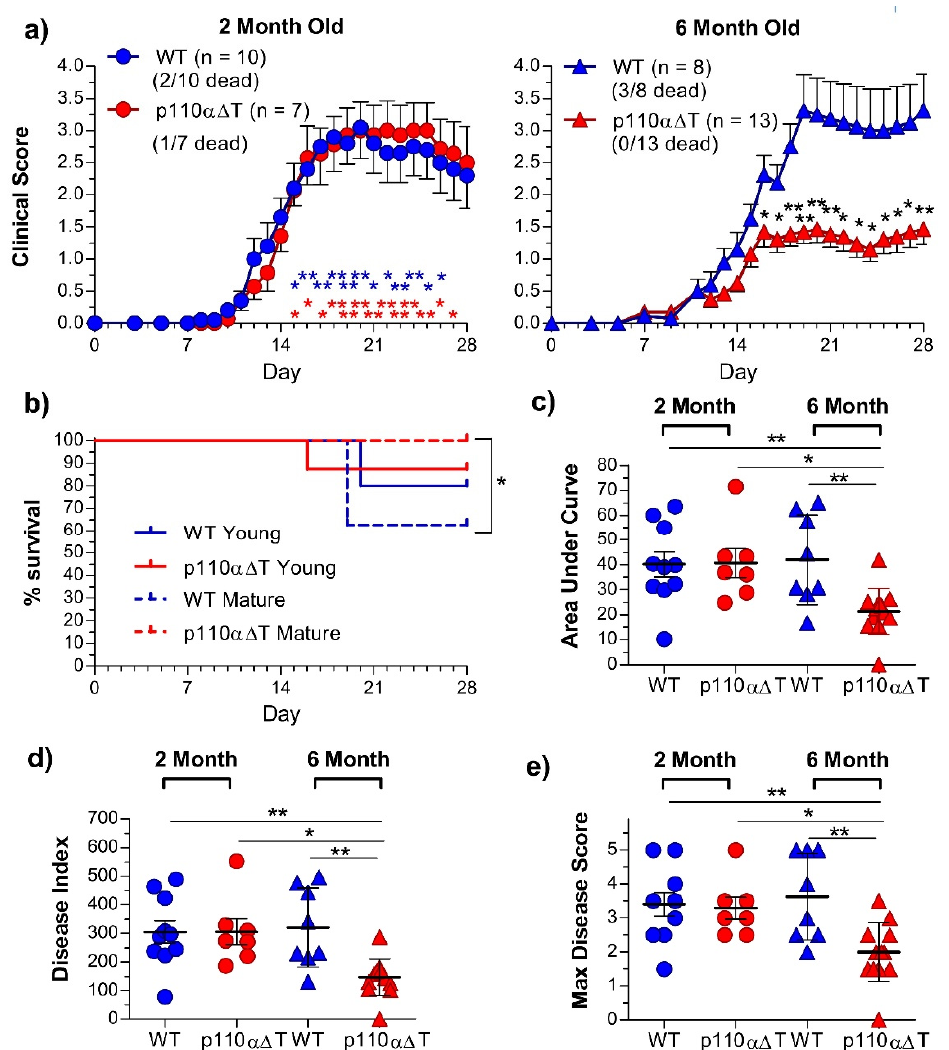
Figure 2. Comparison of Experimental Allergic Encephalomyelitis (EAE) disease parameters in young or mature wild type (WT) and p110 αΔ T mice, ( a ) Daily average Disease Score; ( b ) Percent Survival; ( c ) Area Under the Curve; ( d ) Disease Index; ( e ) Maximum Disease Score. In ( a ), the mean ± SEM of daily disease scores for each group is represented; deaths and the number of mice in each group are given in parentheses. The left graph in ( a ) shows data from young WT (blue circles) or p110 αΔ T mice (red circles); the right graph shows data from mature WT (blue triangles) or p110 αΔ T mice (red triangles). ( b ) Survival of young (solid lines) or mature (dotted lines) WT (blue lines), or p110 αΔ T mice (red lines) is shown. In ( c – e ), the data from individual young (circles) or mature (triangles) WT (blue symbols) or p110 αΔ T mice (red symbols), as well as the mean ± SEM for each group, are depicted. Data from two different experiments each of young and mature mice; individ- ual data from young WT ( n = 10, blue circles), young p110 αΔ T ( n = 7, red circles), mature WT ( n = 5, blue triangles), and mature p110 αΔ T mice ( n = 8, red triangles) are shown. Only significant differ- ences between groups are indicated, as determined by One-way ANOVA ( a , c – e ; * p < 0.05, ** p < 0.01) or the log rank (Mantel–Cox) test ( b ; * p < 0.05). In ( a ), asterisks in blue indicate significant differences between young WT and mature p110 αΔ T mice; red asterisks indicate significant differ- ences between young and mature p110 αΔ T mice; black asterisks indicate significant differences be- tween mature WT and p110 αΔ T mice.